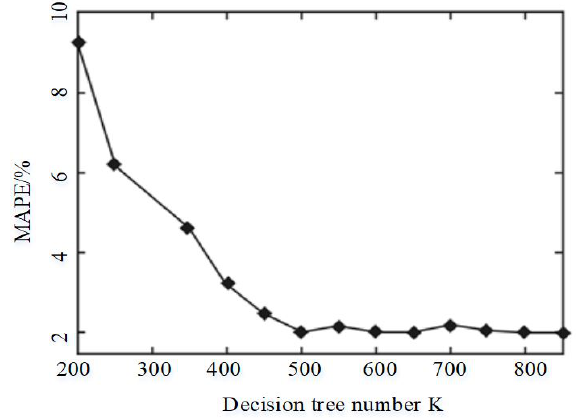
Fig. 3. Relationship between generalization error and decision tree number